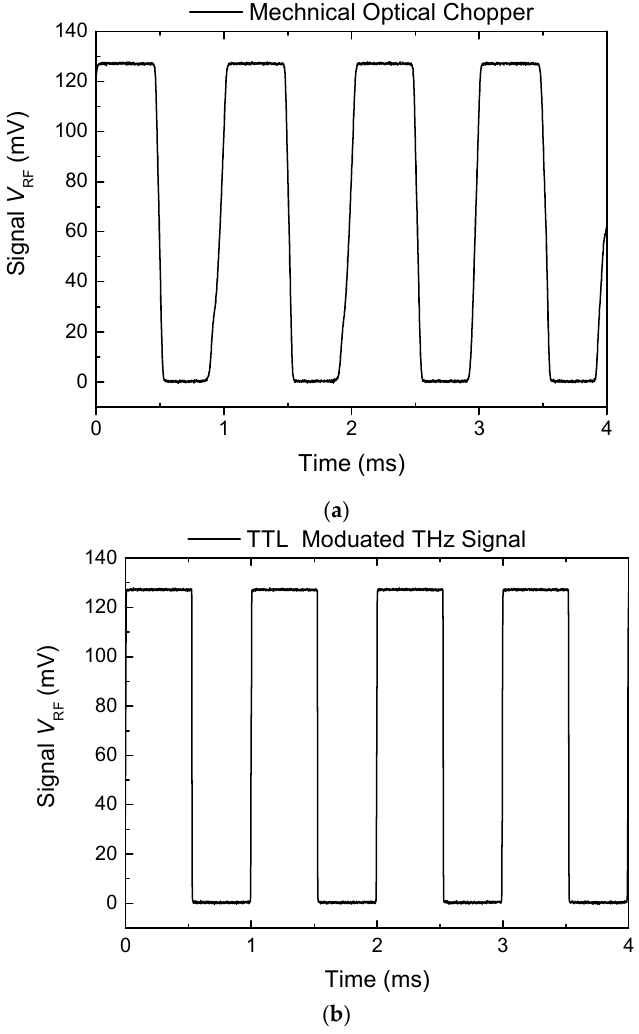
Figure 9. Real-time detector voltage output V RF (t) traces of the modulated THz beam using a mechanical optical chopper ( a ) and an electronic signal via the TTL port on the AMC THz source ( b ).